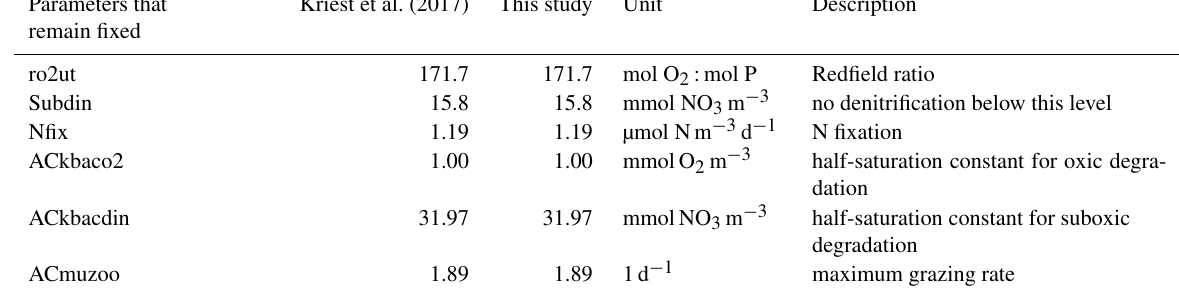
Table 2. Model adjustment of biogeochemistry with aggregates compared to Kriest et al. (2017) and new parameters in this study. Parameters that Kriest et al. (2017) This study Unit Description 171.7